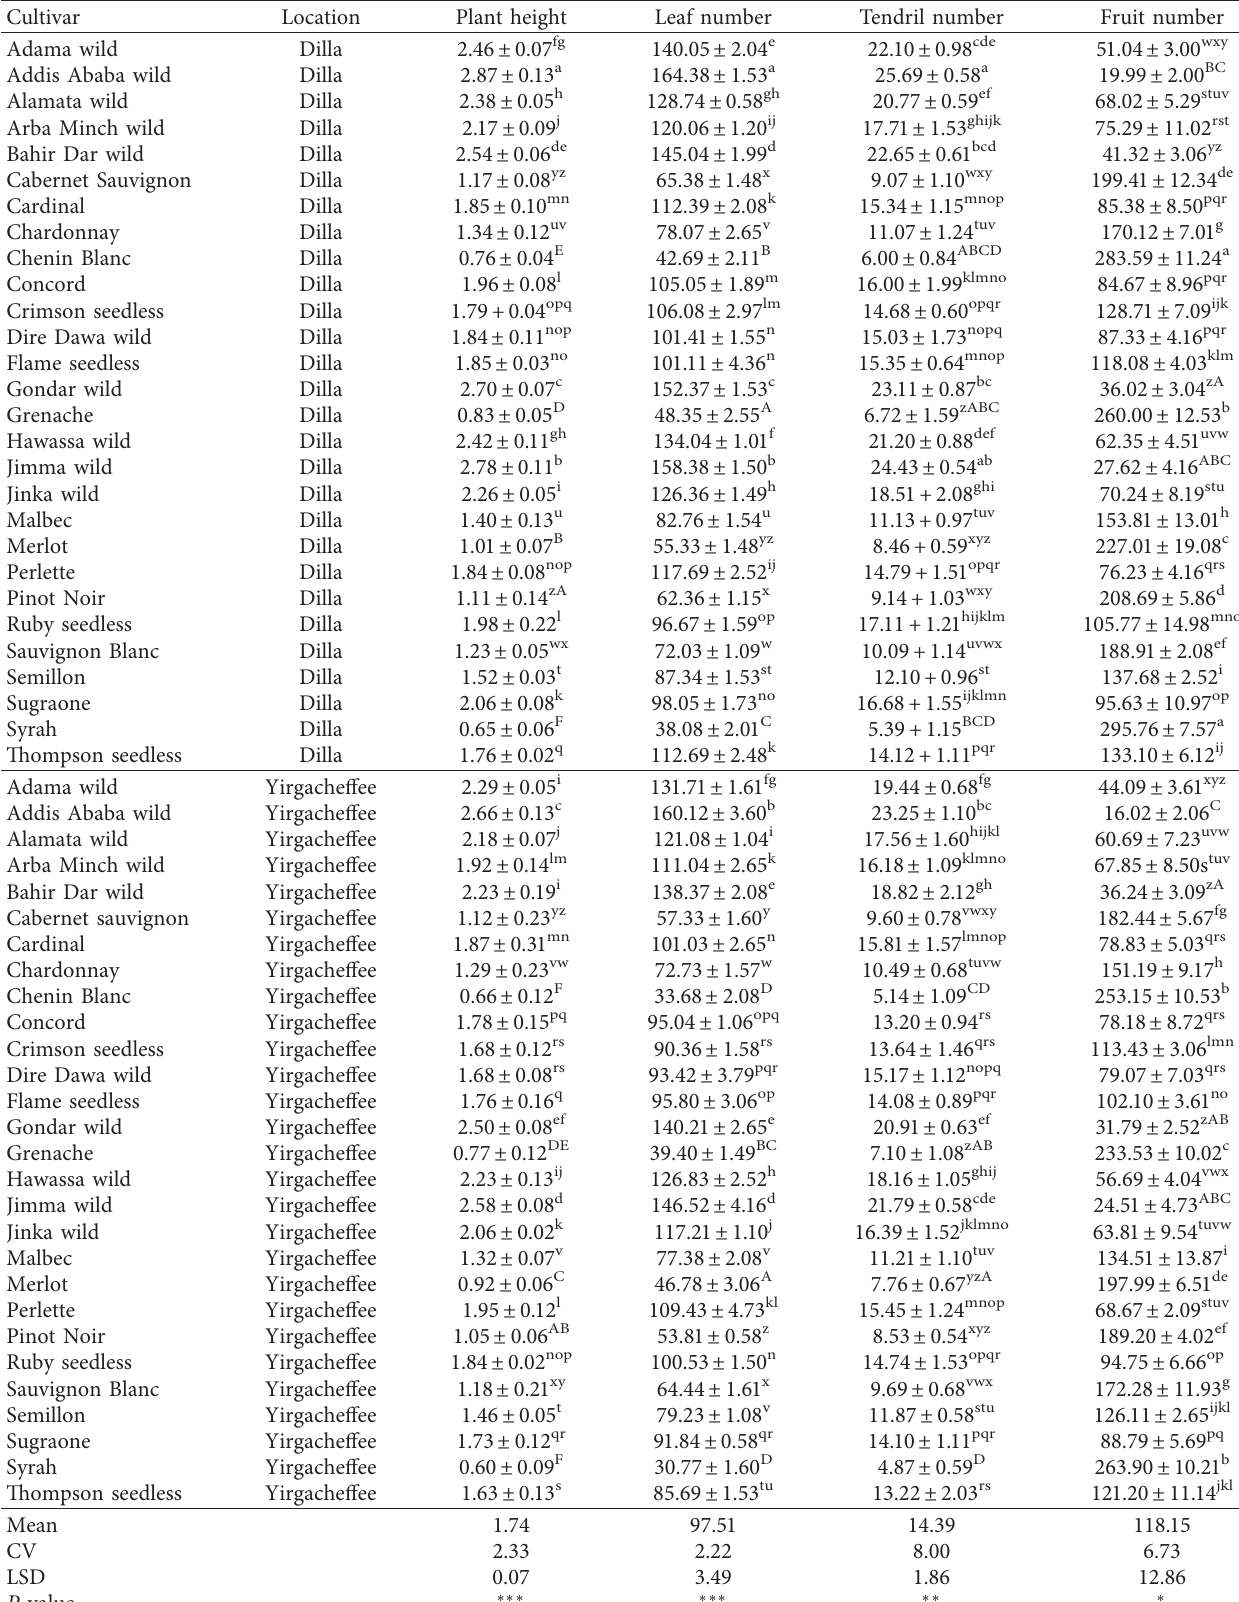
Table 1: Interaction effect of cultivar and location on grapevine plant height, the number of leaves, tendrils, and fruit per plant.